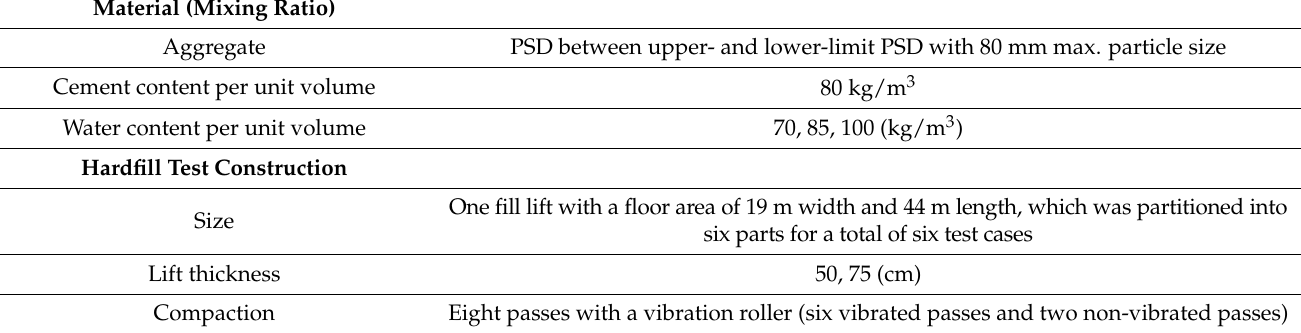
Table 4. Conditions of field test construction.